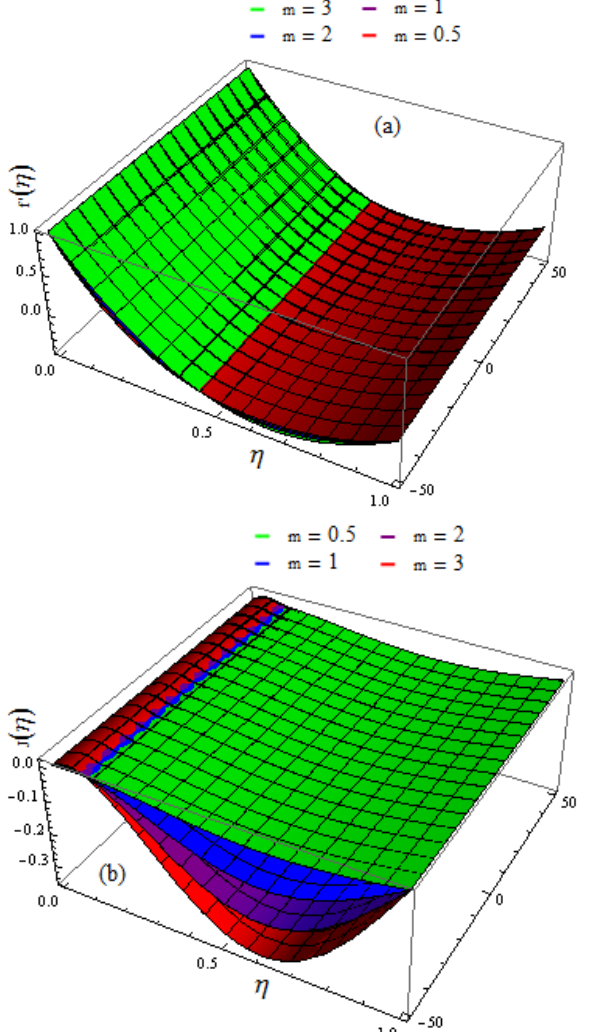
′ (𝜂) . ( b ) Influence of 𝑚 on 𝐽(𝜂) . Figure 9. ( a ) Influence of m on f (cid:48) ( η ) . ( b ) Influence of m on J ( η ) . Figure 9. ( a ). Influence of 𝑚 on 𝑓 Figure 9. ( a ). Influence of 𝑚 on 𝑓